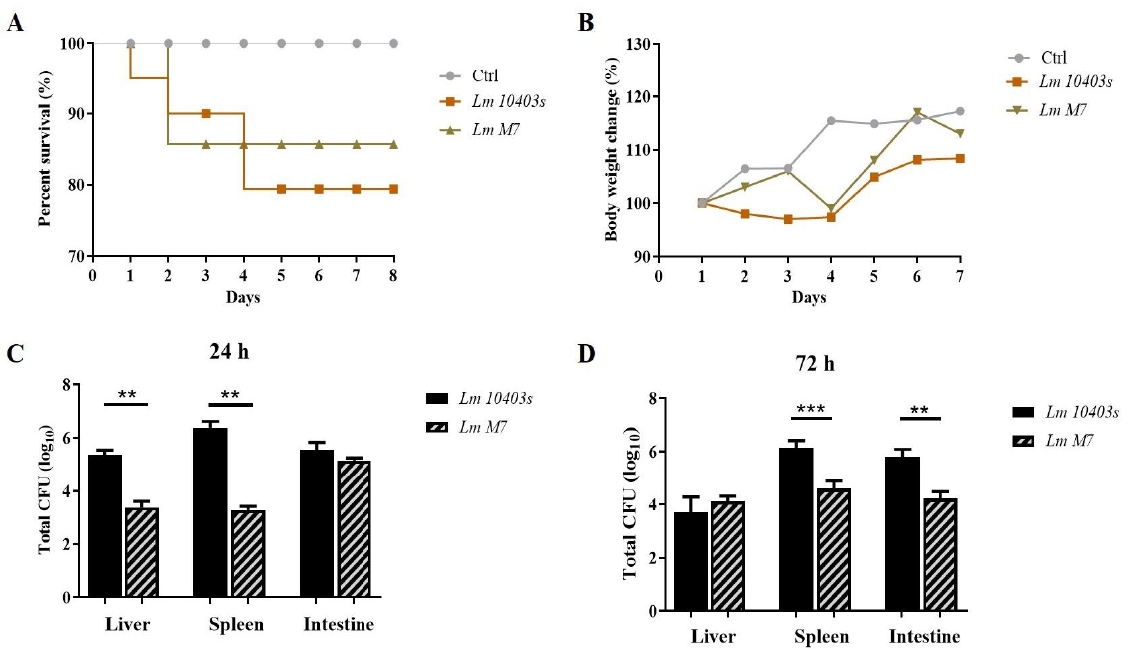
Figure 1. L. monocytogenes infection in mice. ( A ) Time course of survival rate of mice. ( B ) Time course of body weight change in mice. ( C , D ) Bacterial load after 24 h and 72 h of infection. ** p < 0.01, *** p < 0.001.